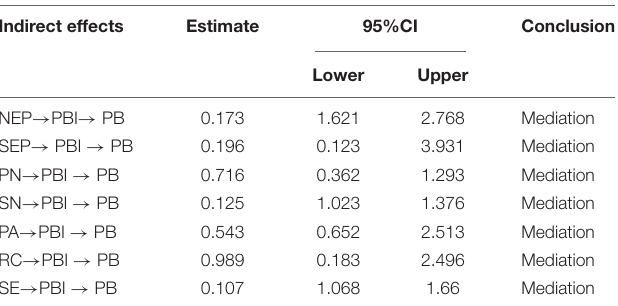
TABLE 8 | Mediation bootstrapping